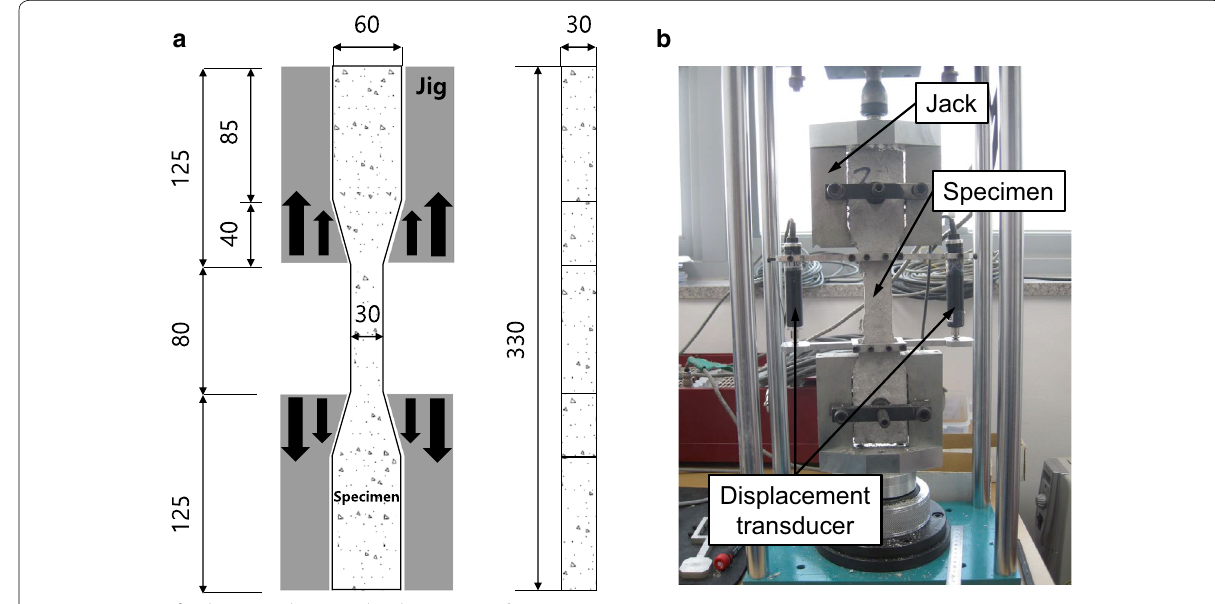
Fig. 2 Specimen for direct tensile test; a details (unit: mm), b test